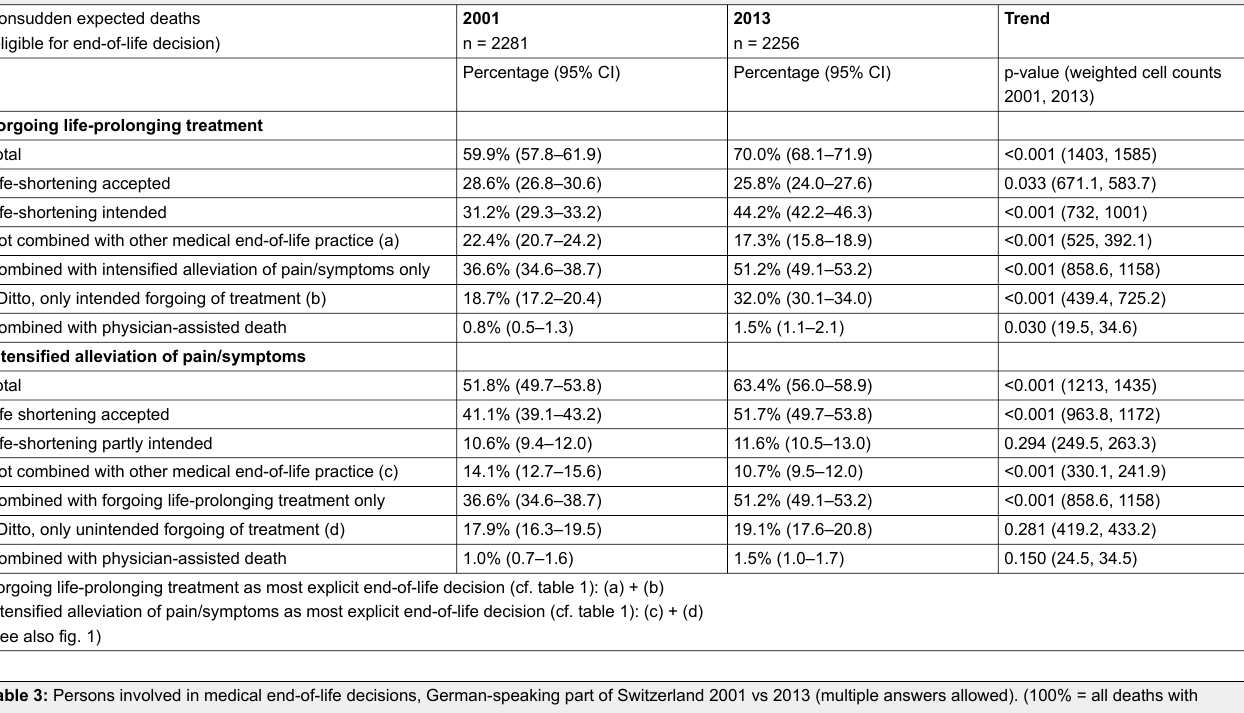
Table 2: Forgoing life-prolonging treatment and intensified alleviation of pain and symptoms, German-speaking part of Switzerland 2001 vs 2013 (100% = all nonsudden expected deaths; percentages weighted and standardized to 2013 deaths). Nonsudden expected deaths (eligible for end-of-life decision)